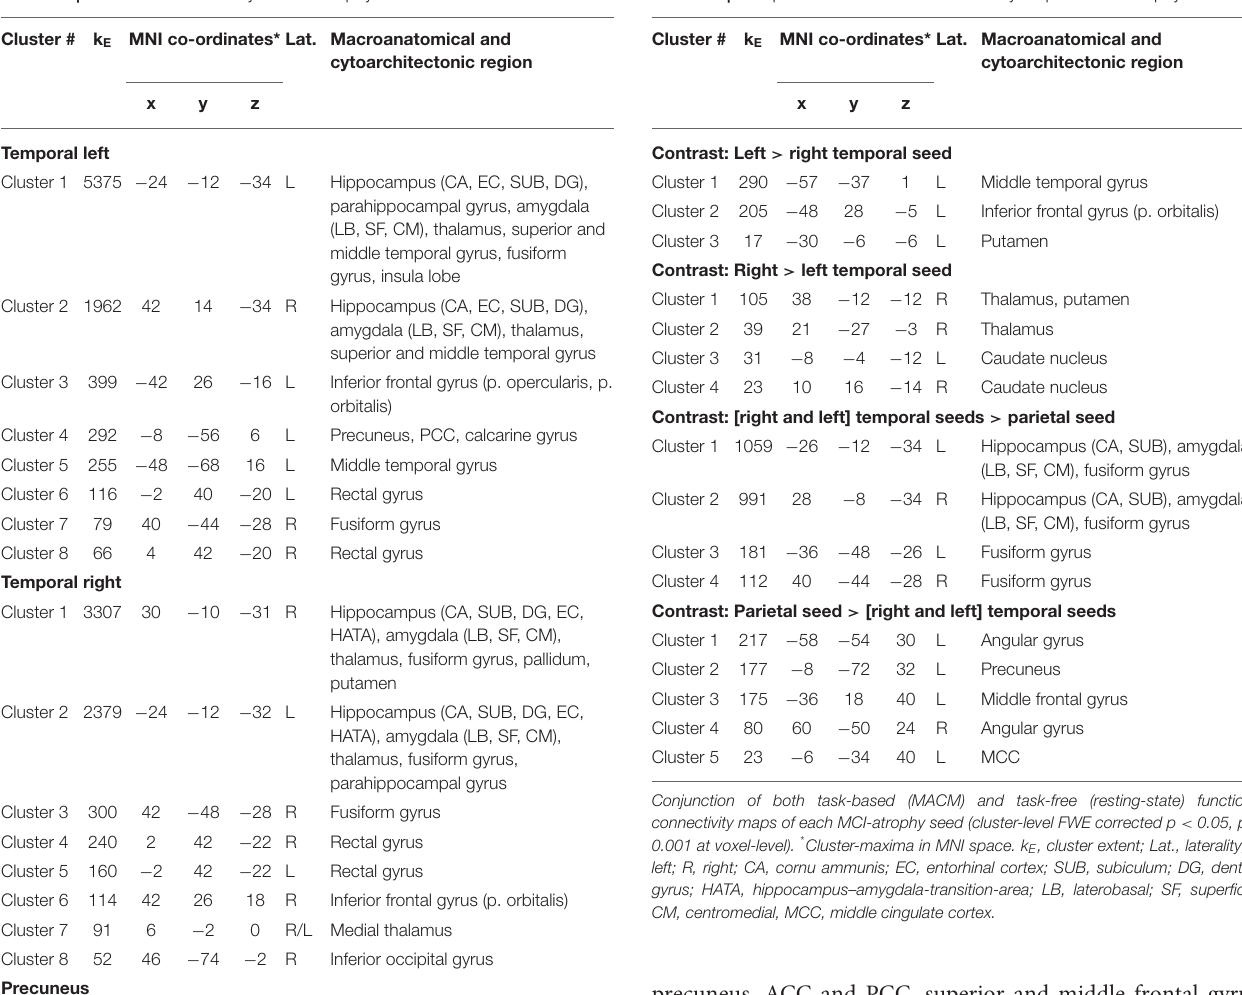
TABLE 1 | Functional connectivity of MCI-atrophy seeds. TABLE 2 | Comparison of functional connectivity maps of MCI-atrophy seeds.